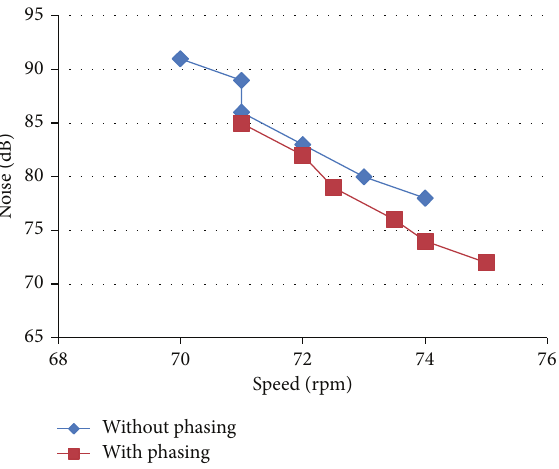
Figure 8: Comparison of speed (rpm) with noise (dB) without and with